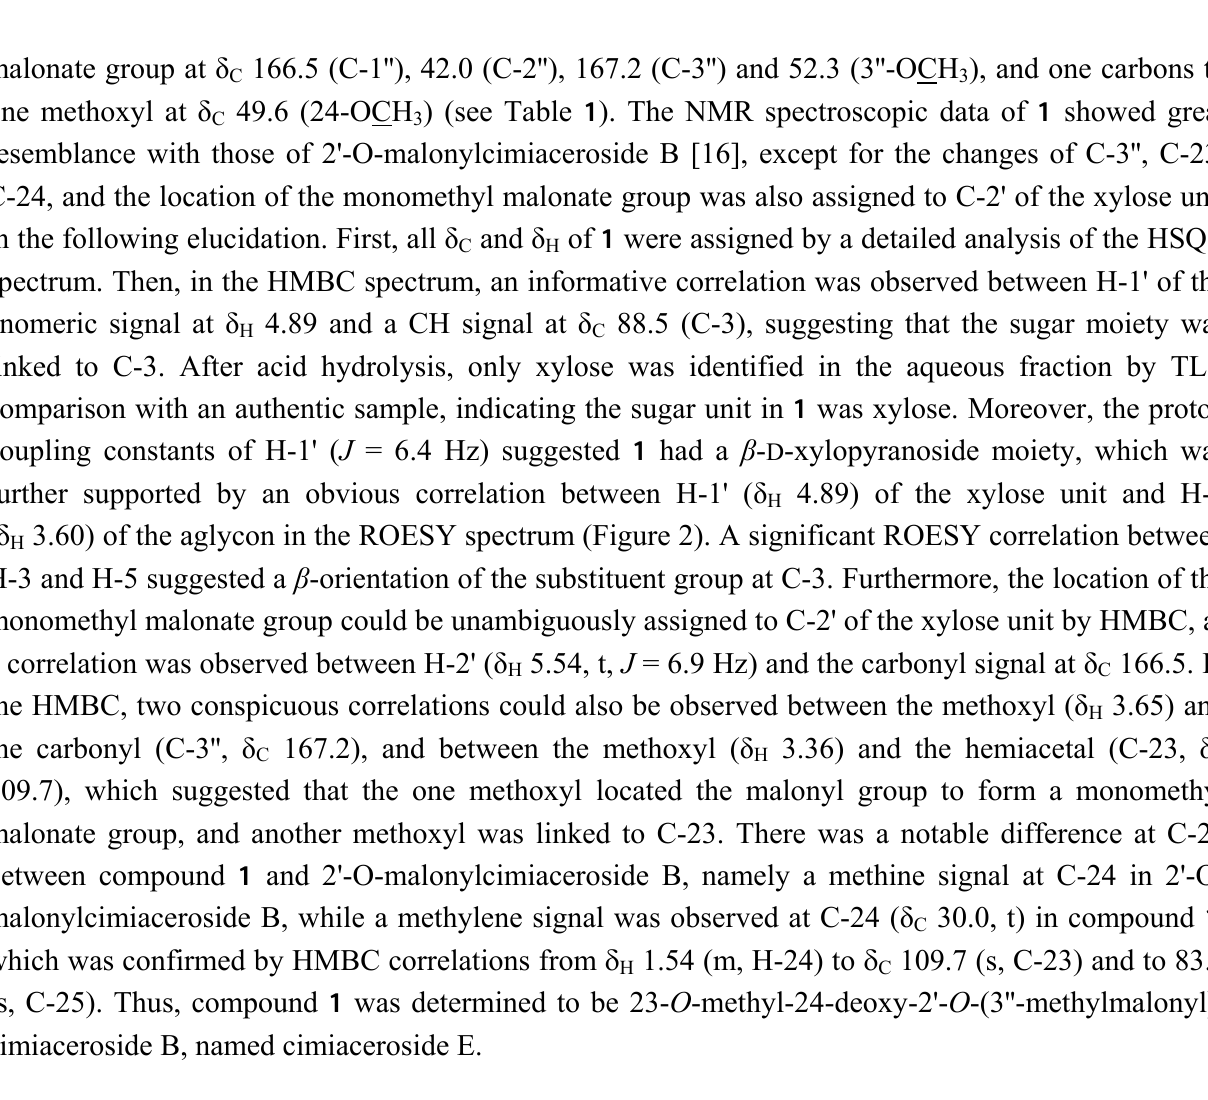
Figure 2. The key HMBC and ROSEY correlations of 1